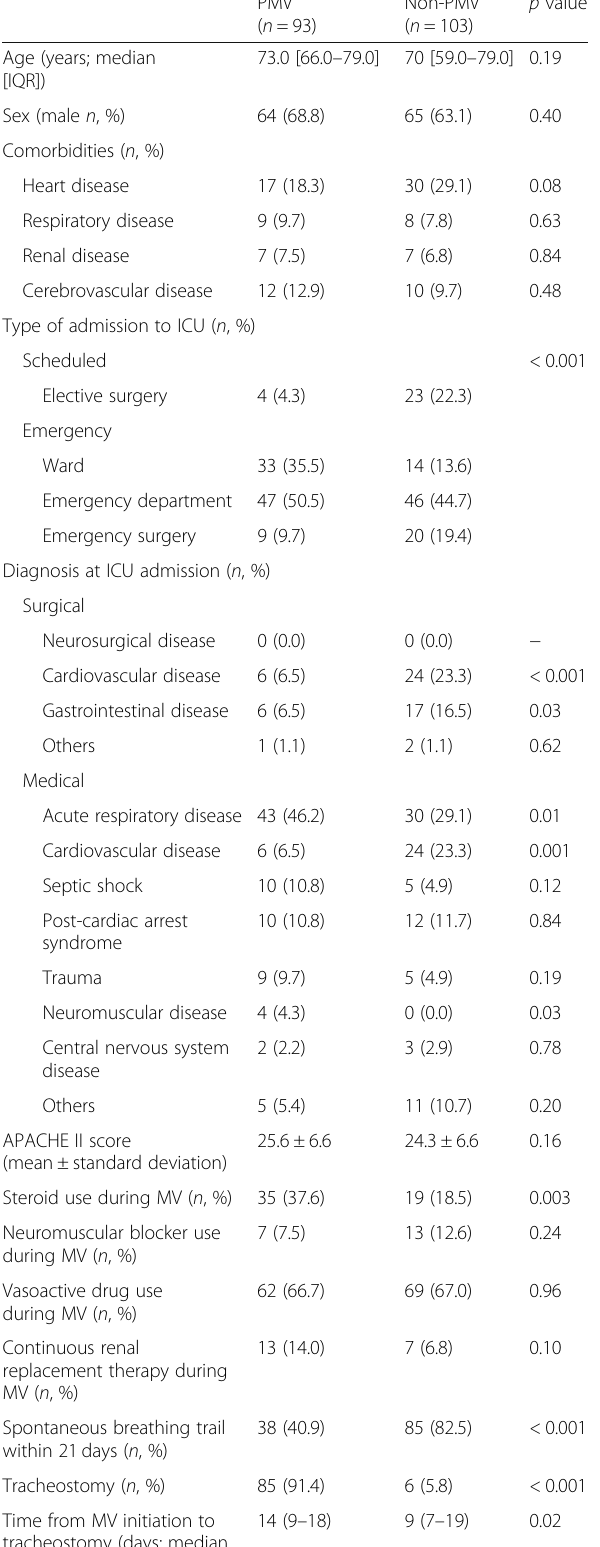
Table 1 Characteristics of the PMV and the non-PMV patients (Continued)